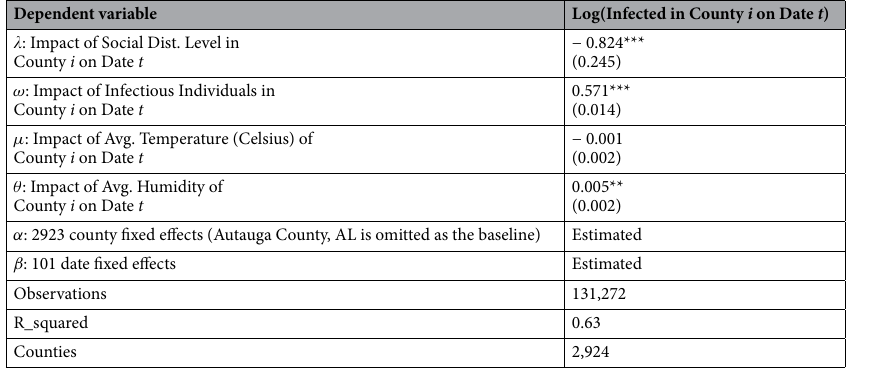
Table 1. Estimation of a modified SIR model. *** p < 0.01, ** p < 0.05, * p < 0.1.